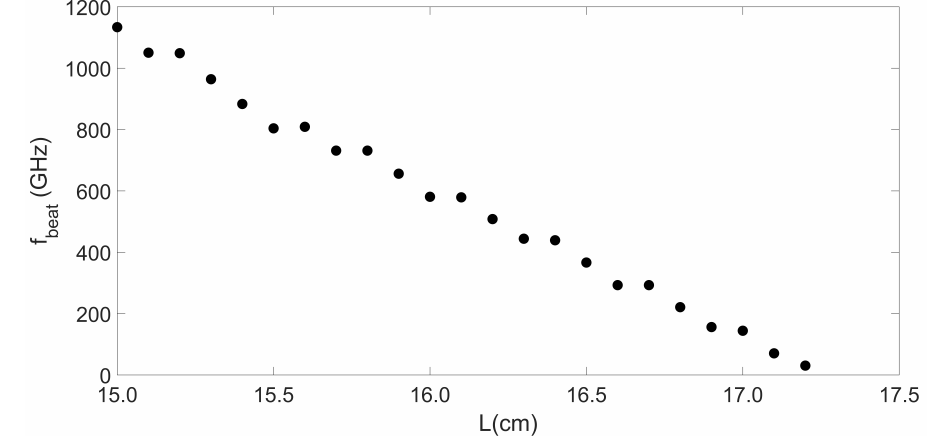
Figure 5. Relationship between f beat and L